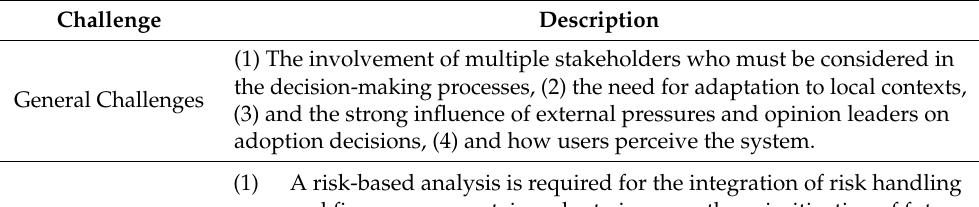
Table 5. Challenges for DSS in wildland fires according to Pacheco et al. [37].